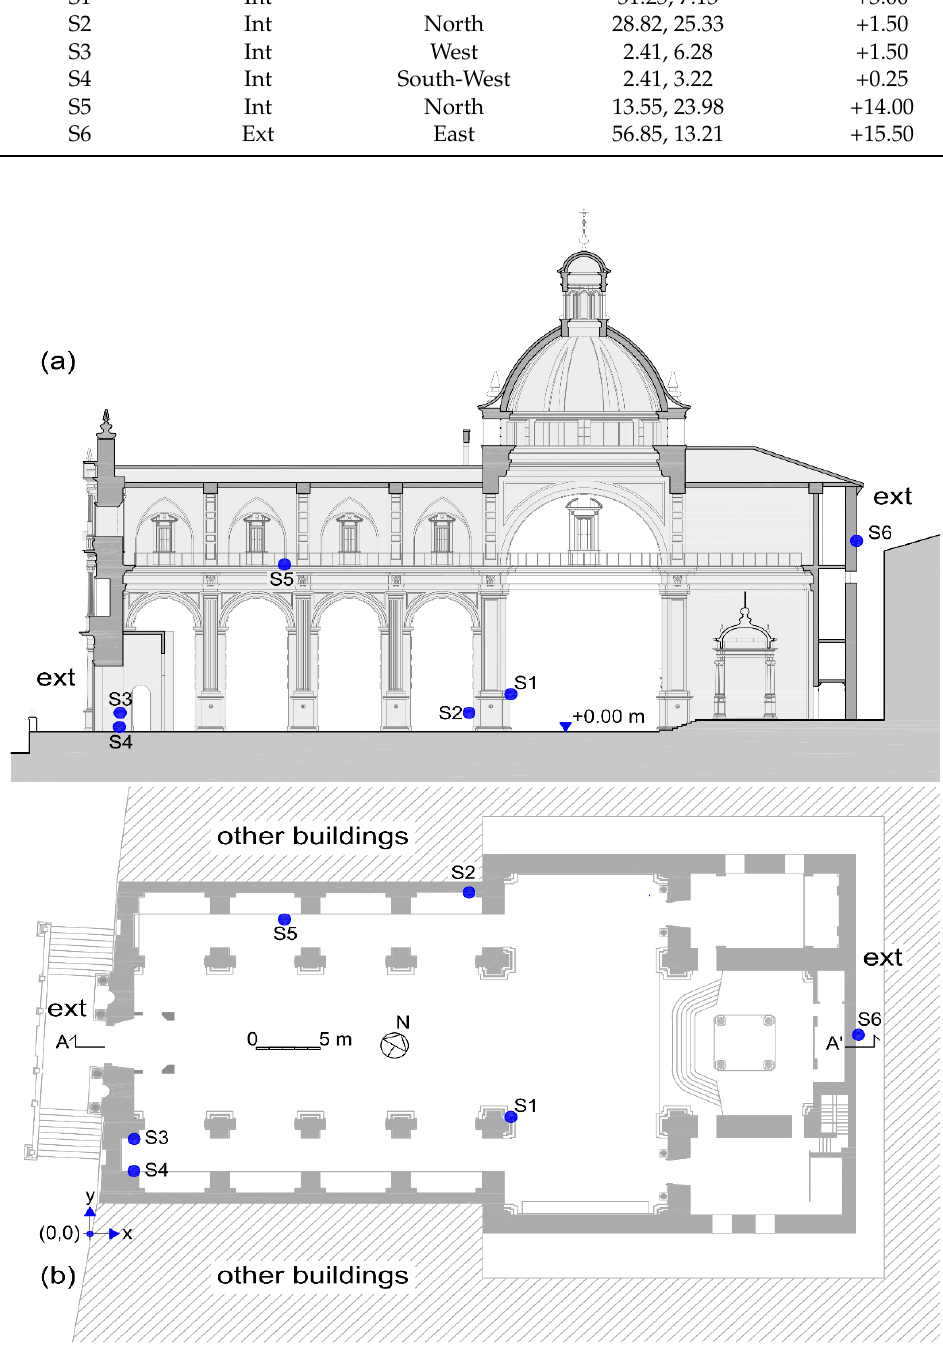
Figure 2. Sensors location in the building: ( a ) section A-A’ and ( b ) plan view.